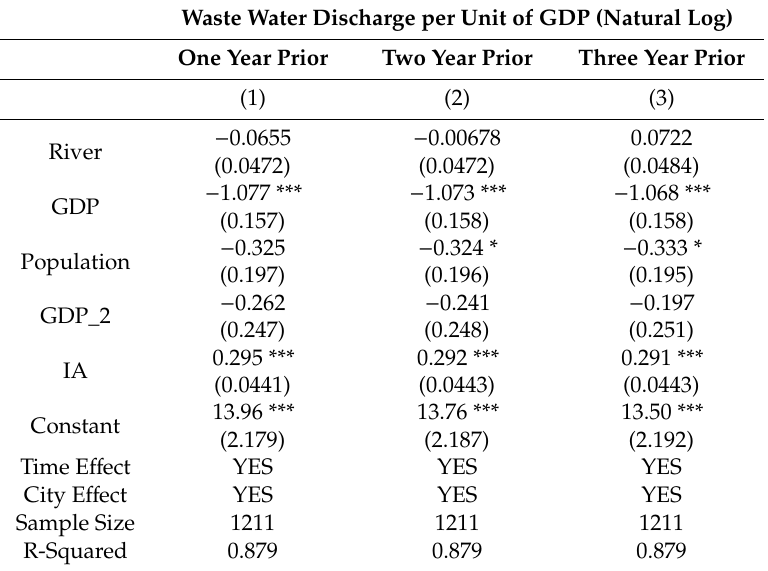
Table 6. Parallel trend test: counterfactual